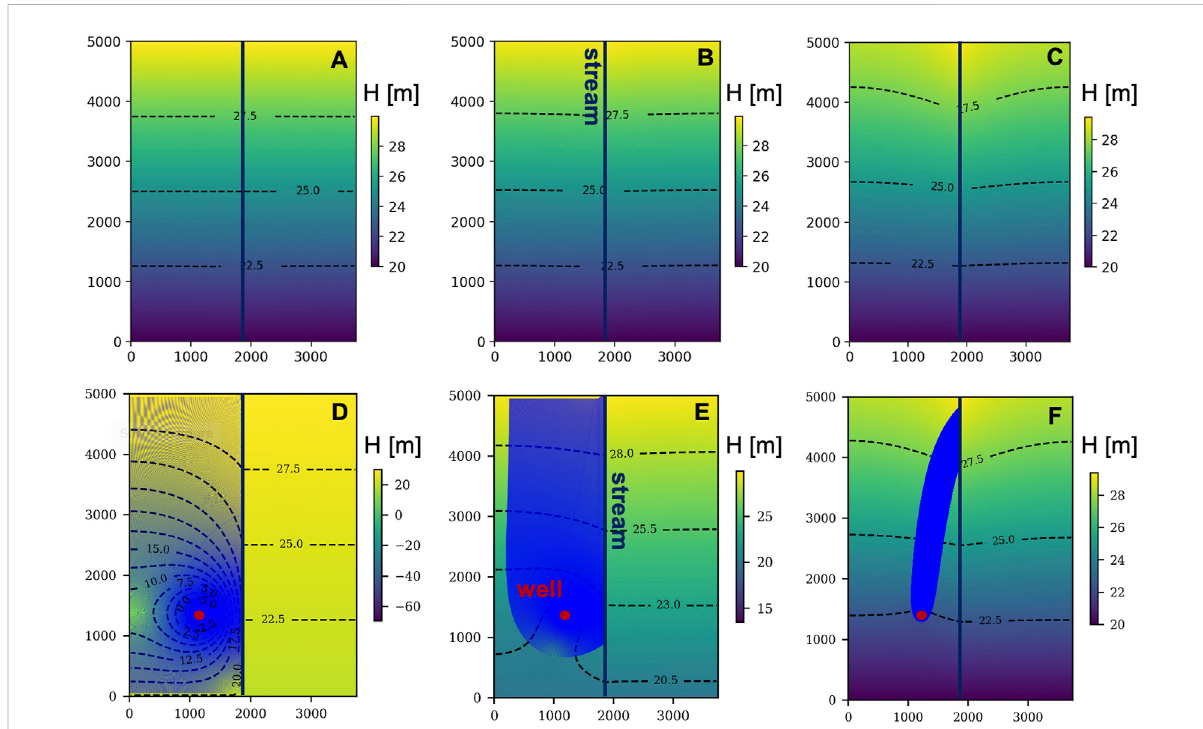
FIGURE 3 The spatial distribution of the hydraulic head H ( x , y ) for hydraulic conductivity K set to 10 – 5 m s − 1 (A,D) , 10 – 4 m s − 1 (B,E) and 10 – 3 m s − 1 (C,F) . Cases (A,B,C) are without pumping, while a pumping rate of 90 m 3 h − 1 is set for cases (D,E,F) . The red dot represent the pumping well locations, the vertical bold black line represents the stream and the blue lines in cases (D,E,F) are the path of the particles from the backward particle tracking.